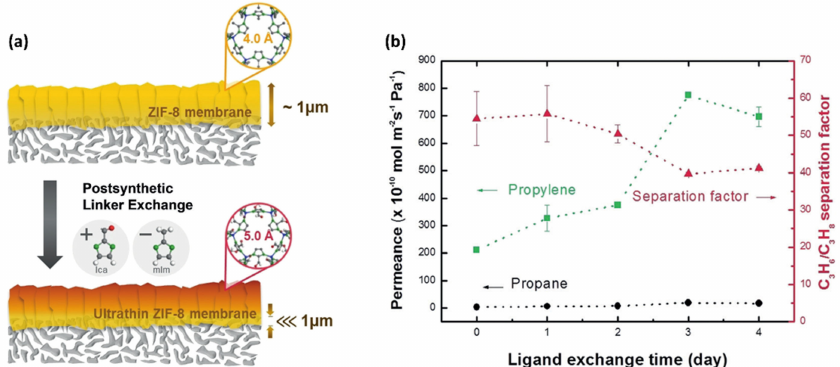
Figure 12. ( a ) Illustration of the postsynthetic ligand exchange of mIm (ZIF-8 linker) of ZIF-8 membranes with Ica (ZIF-90 linker). ( b ) Binary propylene/propane separation performances of ZIF-8 membranes postsynthetically linker exchanged with Ica for different reaction times